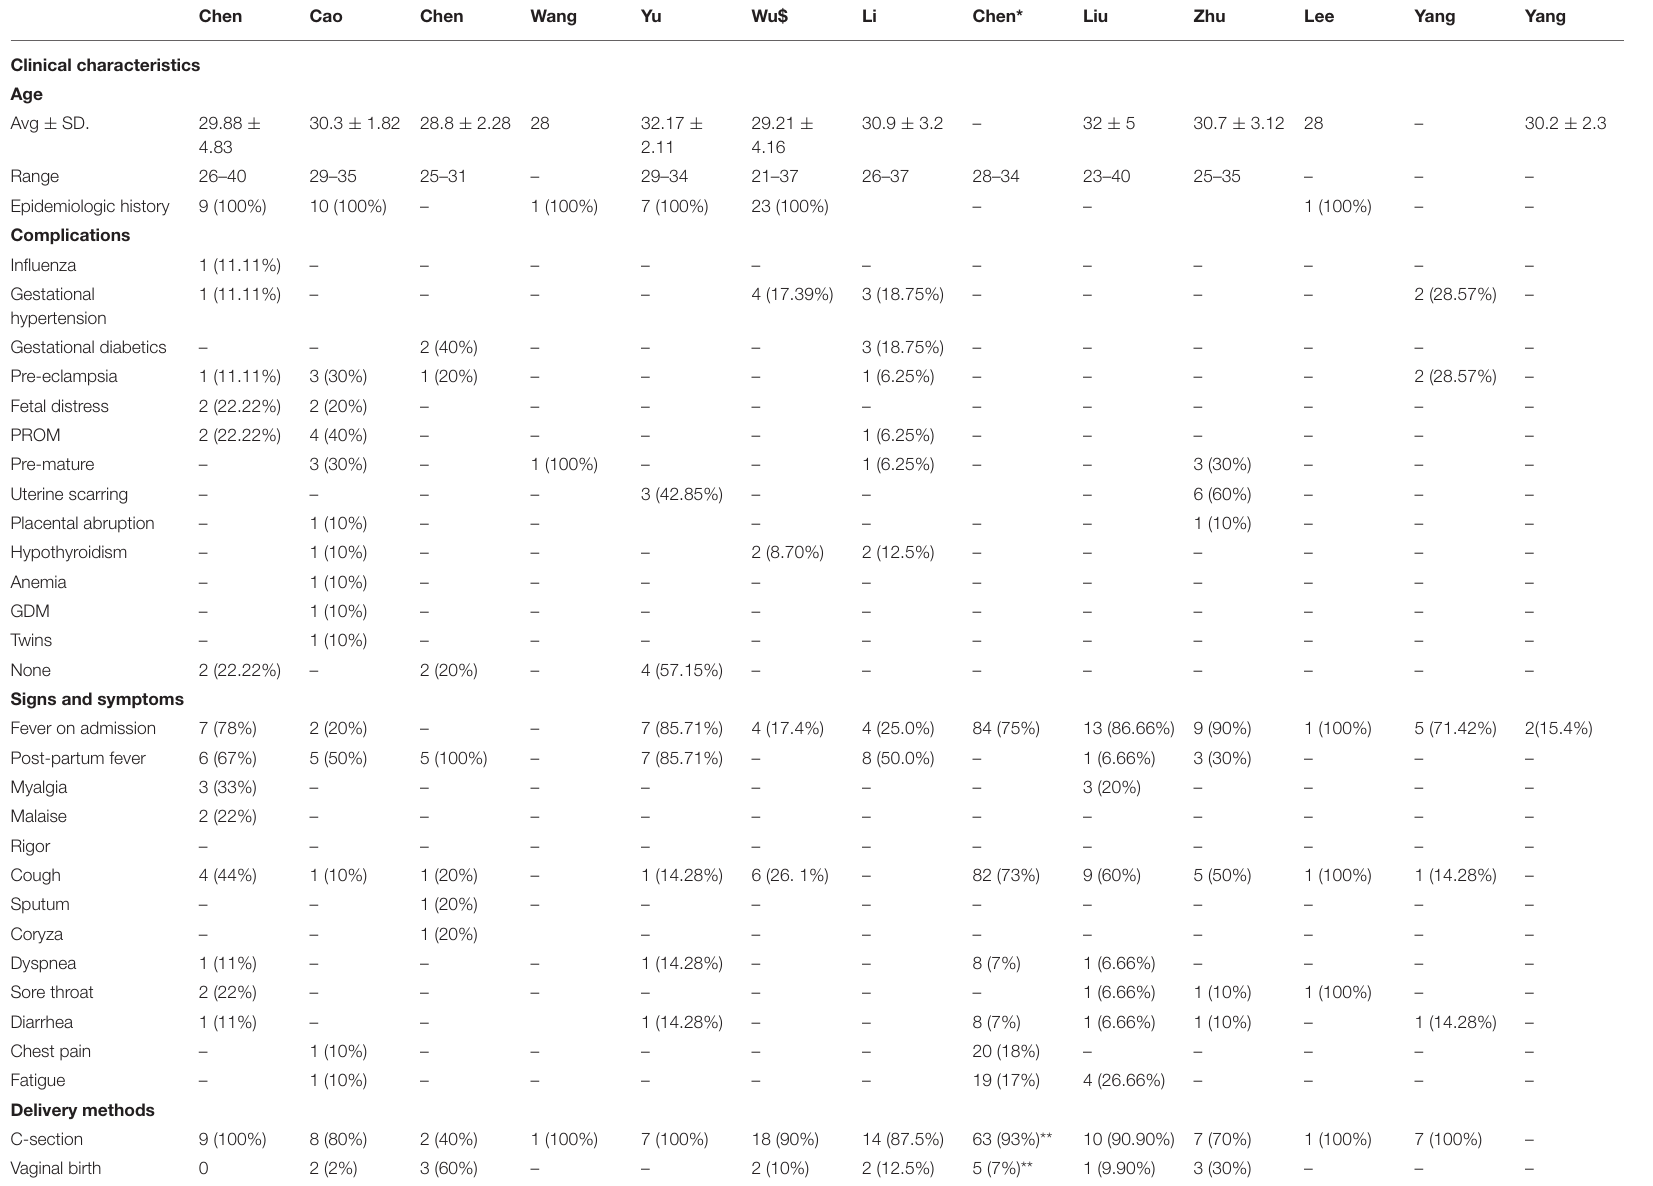
TABLE 1 | Clinical features of 235 mothers with COVID-19